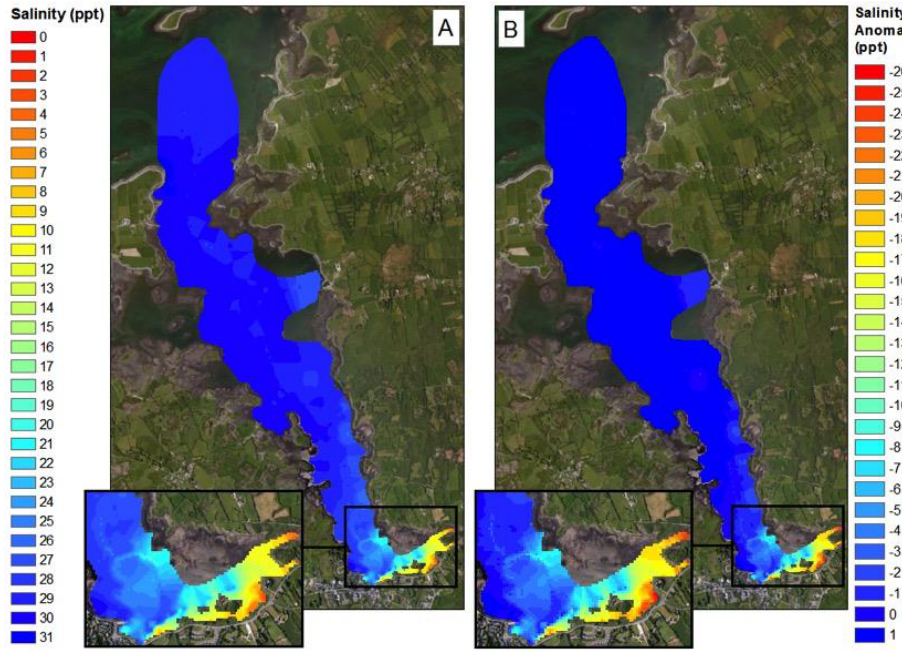
Figure 8. Sea surface salinity map of Kinvara Bay interpolated from in-situ data measurements ( A ); Salinity anomaly map showing surface salinity divergence from the mean ( B ).